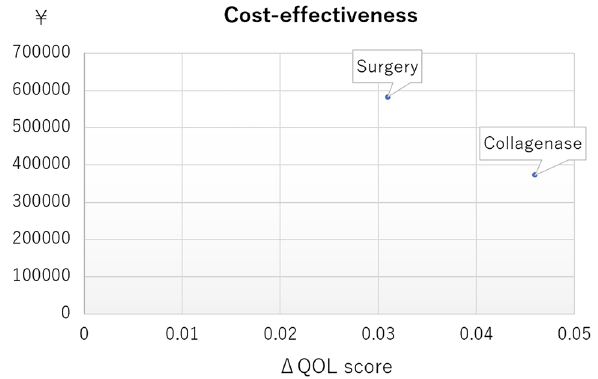
Figure 2. Incremental cost/QOL score at 26 weeks. The Collagenase group was dominant in cost-effectiveness at 26